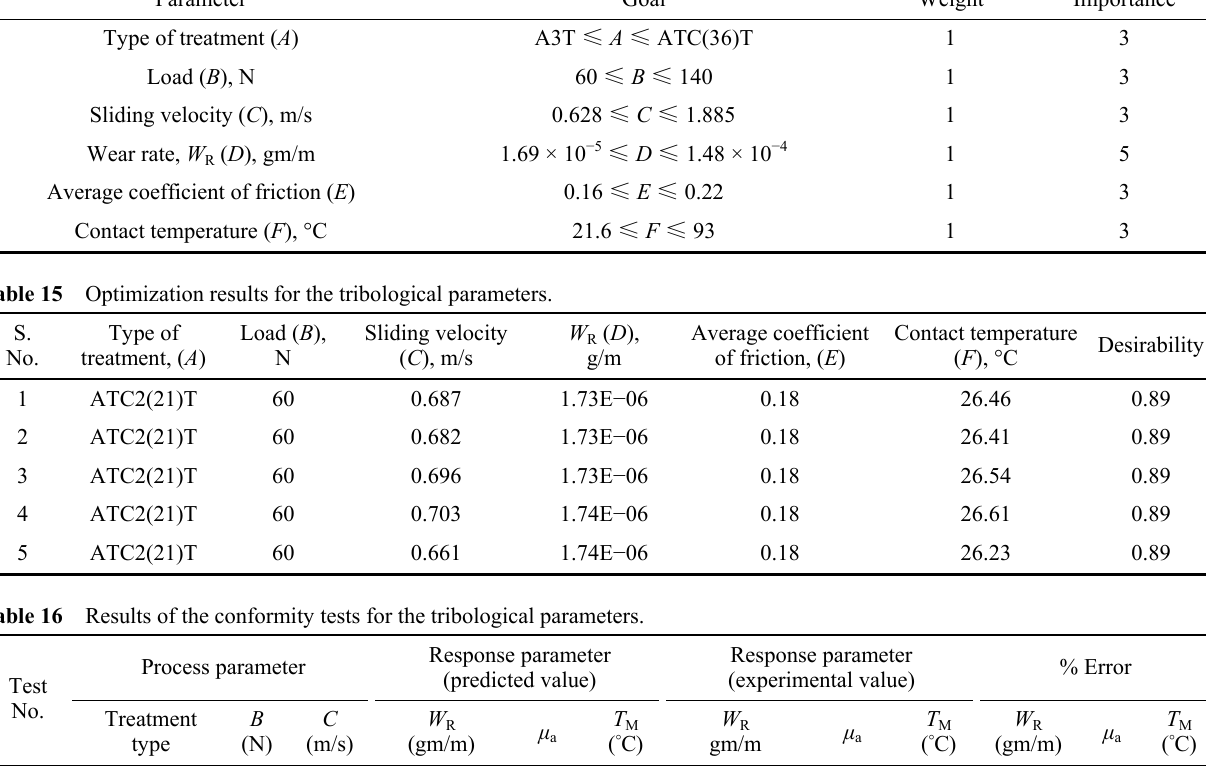
Table 14 Constraints for determining the optimum values of the tribological parameters. Parameter Goal Weight Importance